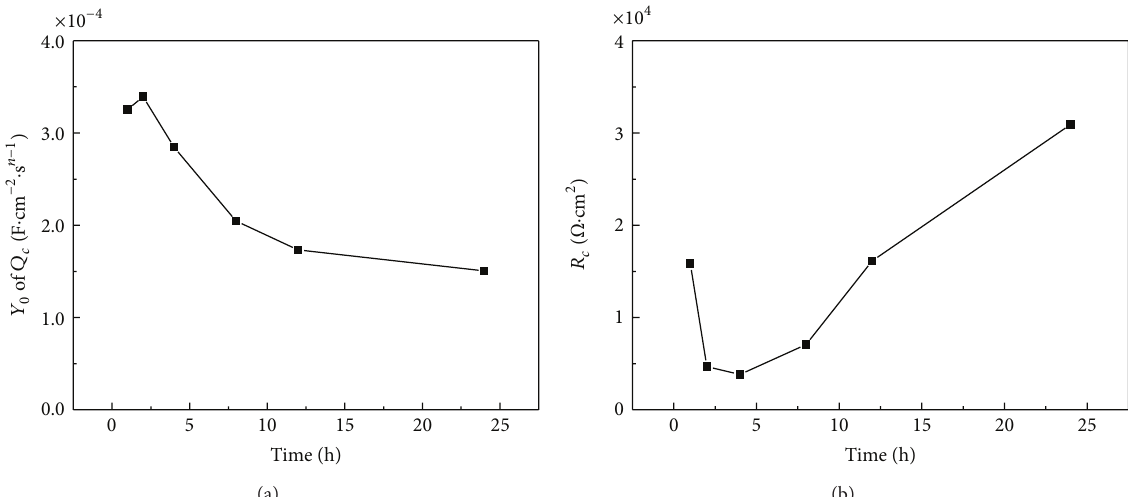
Figure 7: Time evolution of 𝑄 𝑐 and 𝑅 𝑐 of painted samples without scratch values calculated from EIS spectra.